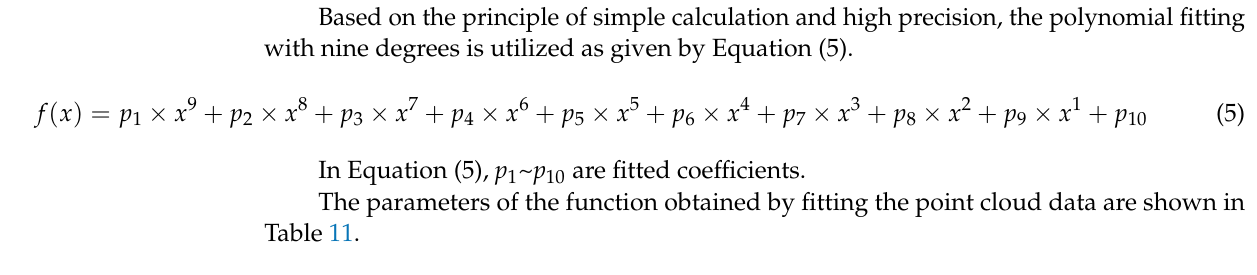
Figure 9. Curve fitting using polynomials of different degrees for the cross-section of NS-LS.